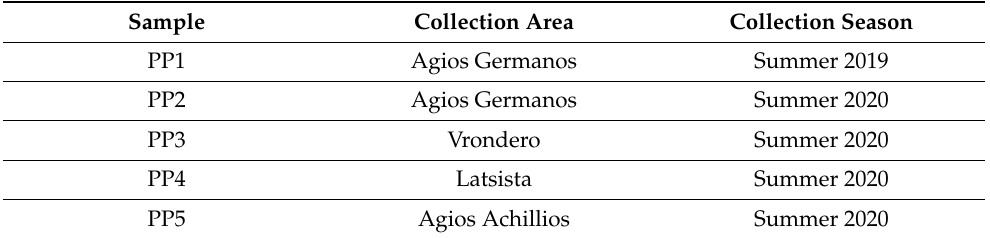
Figure 1. Map of PNP in Northwest Greece and collection areas. Table 6. Propolis collection from stable beehives of PNP.